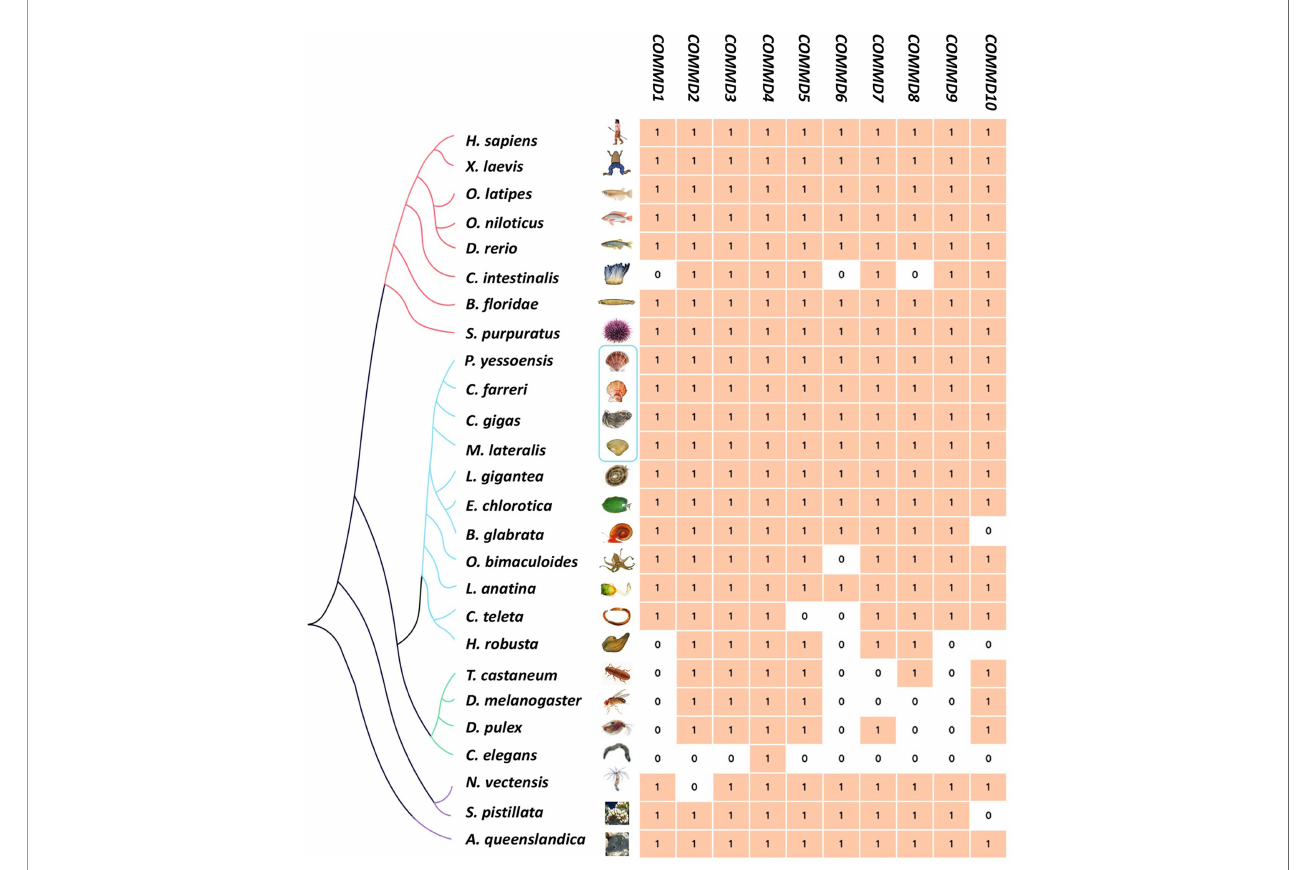
FIGURE 3 | Genome-wide identi fi cation of COMMD gene families of 4 bivalve molluscs (in blue box) and 22 other metazoan species. Different colors of branches represent different metazoan groups (red, Deuterostomia; blue, Lophotrochozoa; green, Ecdysozoa; purple,